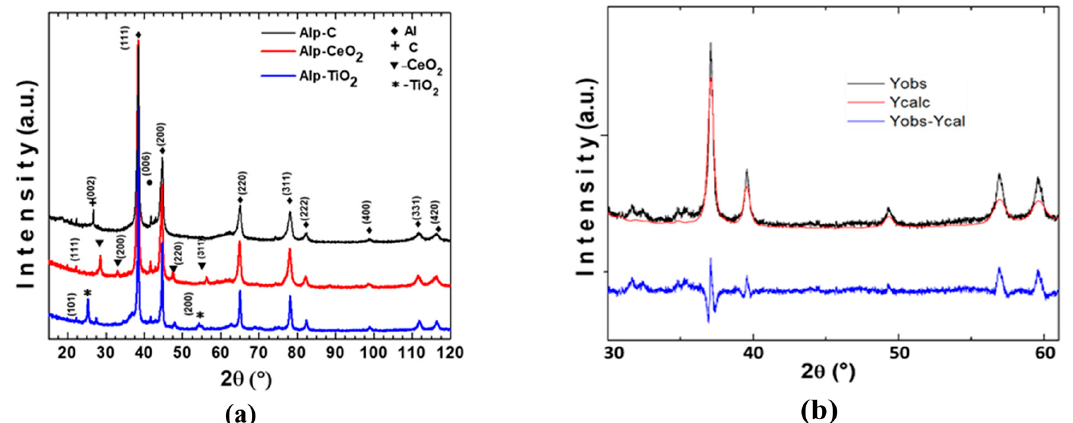
Figure 1. ( a ) XRD patterns from master compound samples after 2 h of milling; ( b ) Rietveld refinement of the Alp-TiO 2 sample.